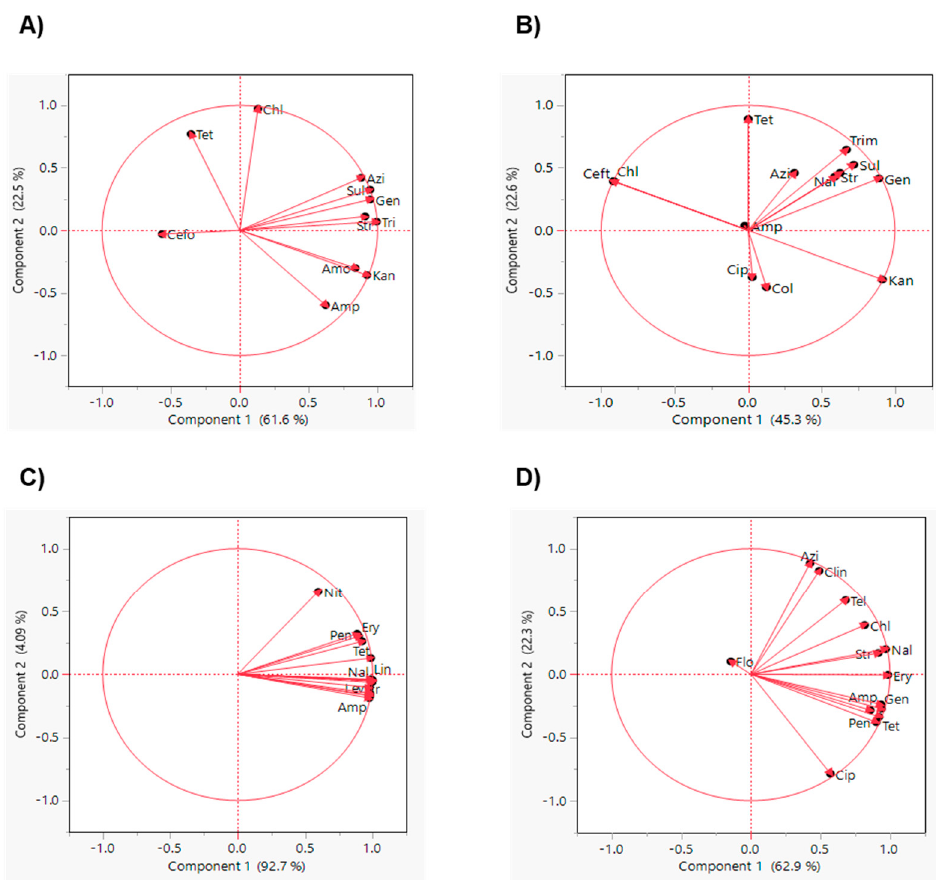
Figure 4. Principal component analysis of relative abundance of phenotypic antimicrobial resistance of ( A ) E. coli O157, ( B ) Salmonella , ( C ) L. monocytogenes, and ( D ) Campylobacter. Amp: ampi-